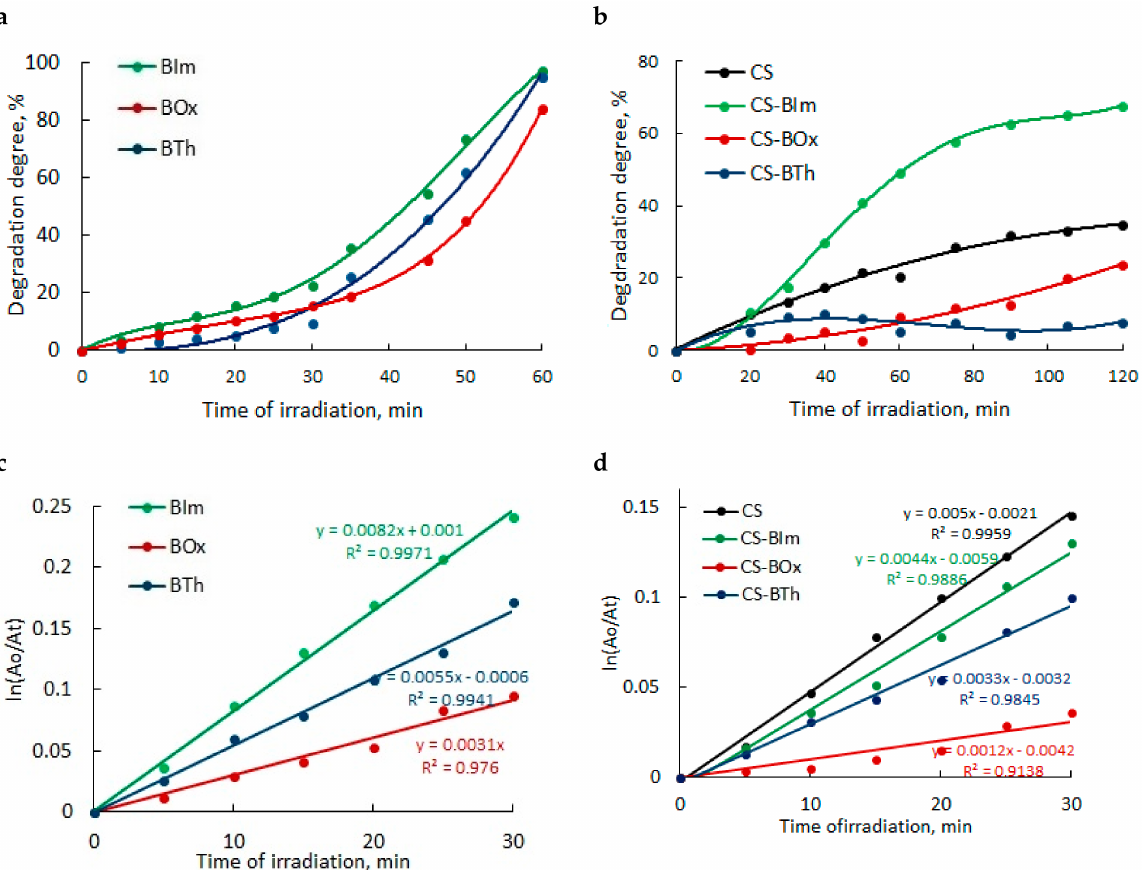
Figure 5. Degree of photodegradation versus irradiation time (expressed as relative absorbance changes) of heterocyclic compounds ( a ) and chitosan samples ( b ) in solution; kinetics of photodegradation of all samples in the initial stage of irradiation up to 30 min ( c , d